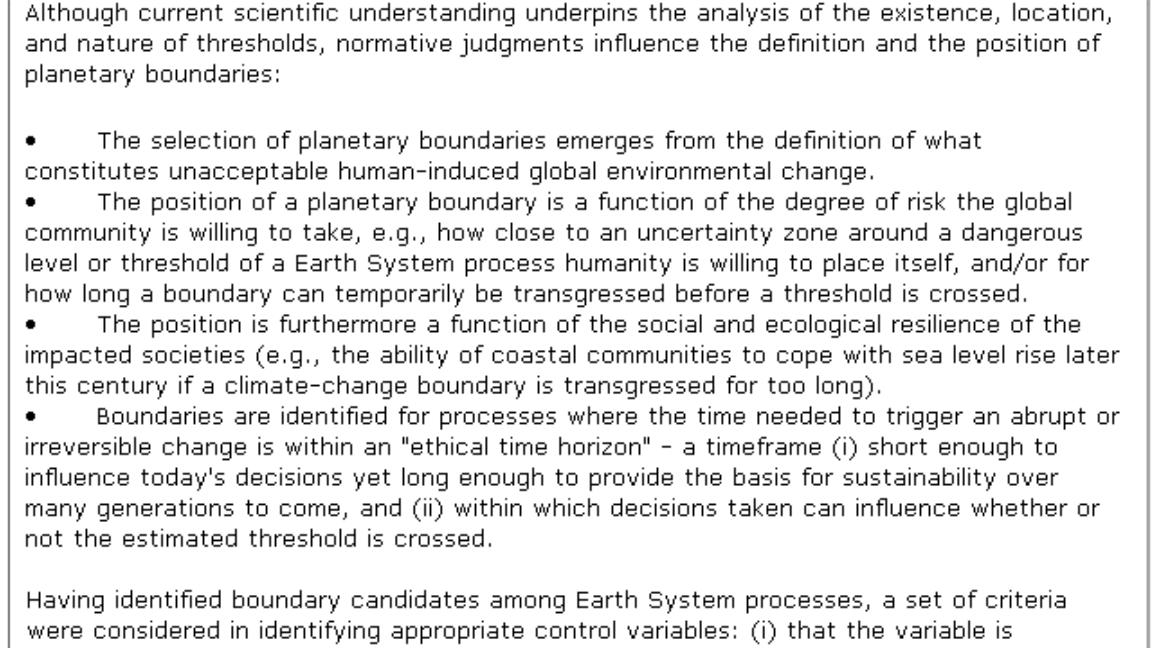
Fig. 3. Summary of criteria and process for the identification and definition of planetary